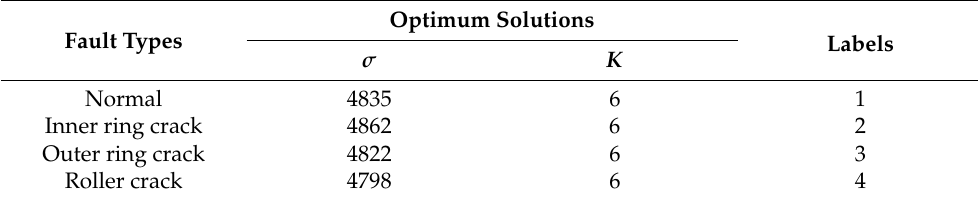
Table 5. Optimal parameter K and σ solutions for different fault types.